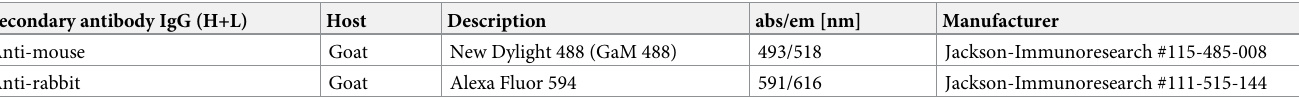
Table 3. Secondary antibodies used in this